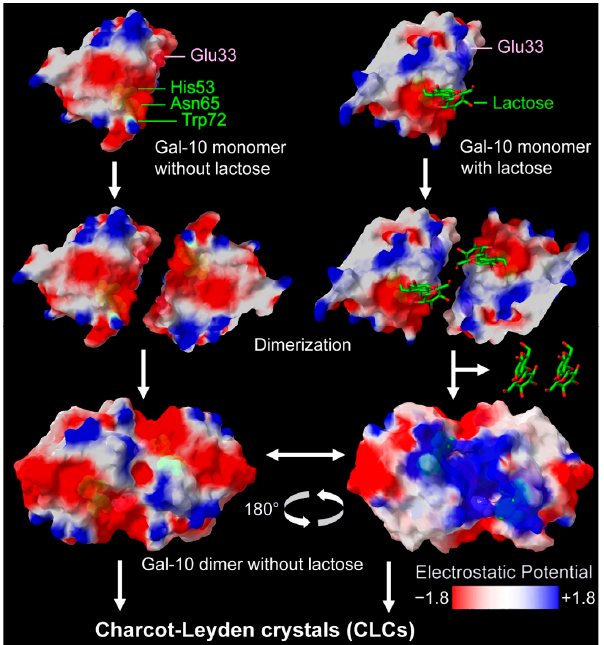
Figure 5. Shift in electrostatic potential may affect Gal-10 dimerization and crystallization. Given that Trp72, His53, and Asn65 bind with lactose (marked with green), the molecular surface and the electrostatic potential were re-computed by replacing Trp72, His53, and Asn65 with Ala to simulate the conditions of carbohydrate binding. Glu33 (marked with pale lavender) from one Gal-10 monomer subunit interacted with the carbohydrate-binding site of the opposing subunit when dimerizing. Then, lactose was expelled from the Gal-10 monomer after dimerization. The red-to-blue color gradient on the molecular surface indicates the electrostatic potential (red: − 1.8; blue: 1.8). Before the replacements, both the carbohydrate-binding site and Glu33 were negatively charged, so they may have repelled each other and, therefore, prevented dimerization. On the contrary, the replacements reduced the negative charge on the area surrounding Glu33, which may have facilitated dimerization. However, whether lactose binding could induce a structural change that facilitates dimerization needs further investigation.